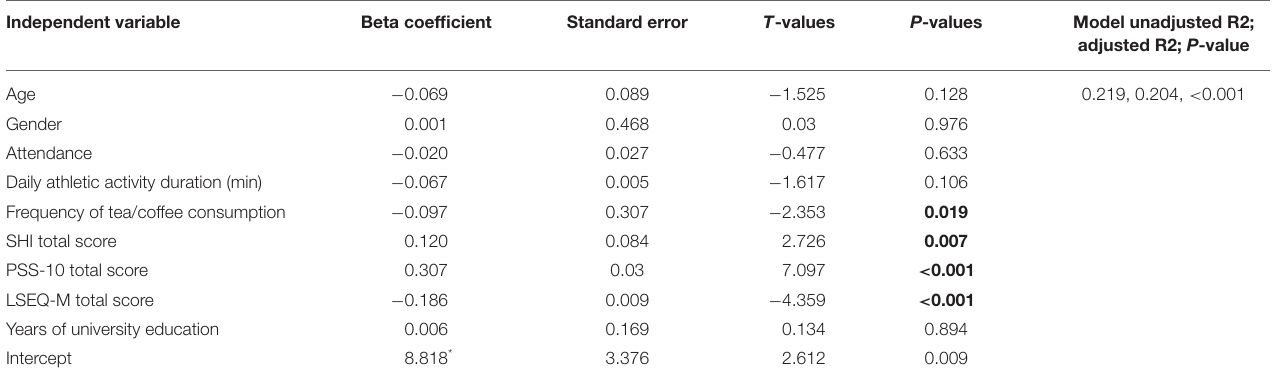
TABLE 3 | Multiple regression predictors of the anxiety level in Ethiopian collegiate young